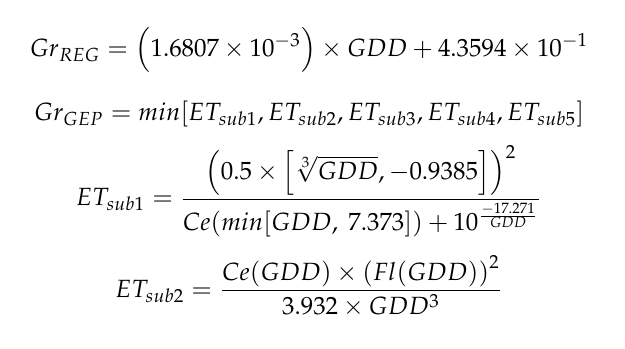
Table 2. Model performances on model testing phase show the similarity between two AI-based ANN and GEP models.